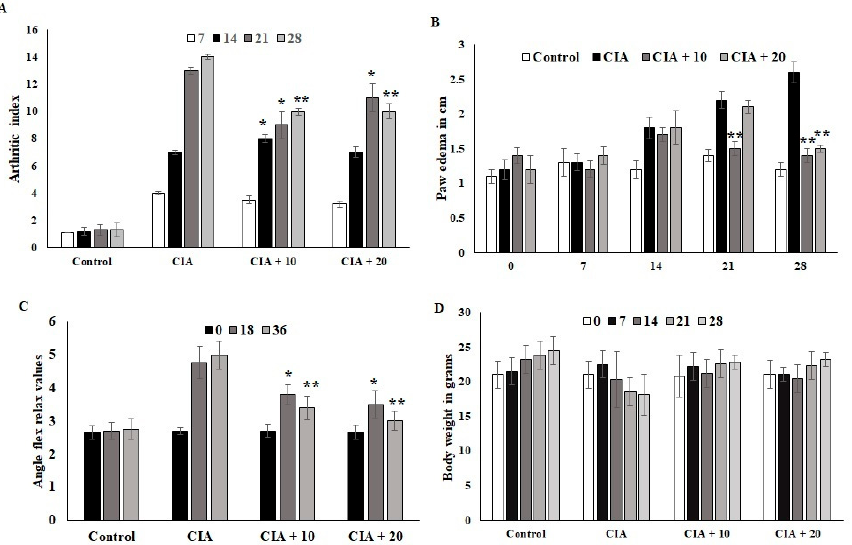
Figure 2. Optunia littoralis (OL) EAE extract suppressed clinical symptoms in collagen-induced mice. Inflammatory arthritic indices of control and CIA-induced mice were evaluated. ( A ) Clinical scoring of joint inflammation was calculated using size in centimeter, redness, hind limb physical movement, lifting and walking, and holding of rods every 10 days. ( B ) Paw edema was calculated according to swelling circumference as determined by Vernier caliper. ( C ) Flex and relax angle was calculated by mobility and climbing activities. ( D ) Body weight was calculated before and after treatment and during every periodic inspection. All the values are expressed as mean ± SEM; each group contained 6 mice; * p < 0.05 and ** p < 0.001, OL- EAE-extract-treated CIA mice compared to disease mice (CIA alone) ( n =